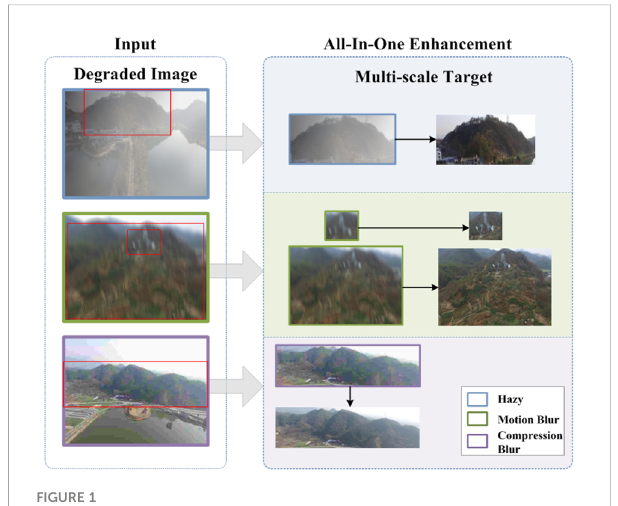
FIGURE 1 An illustration of our motivation. As shown, the forest scene images captured by drones could inevitably suffer from different degradation problems. The target size in the images captured at different locations is variable. Therefore, we explored the restoration of multi-scale target details in aerial images and proposed an all-in- one image enhancement